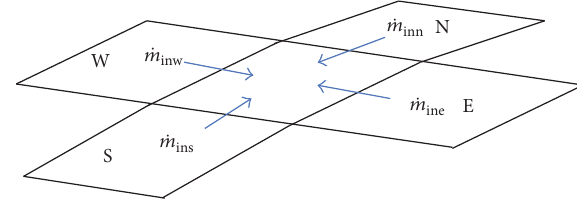
Figure 2: Diagram of control